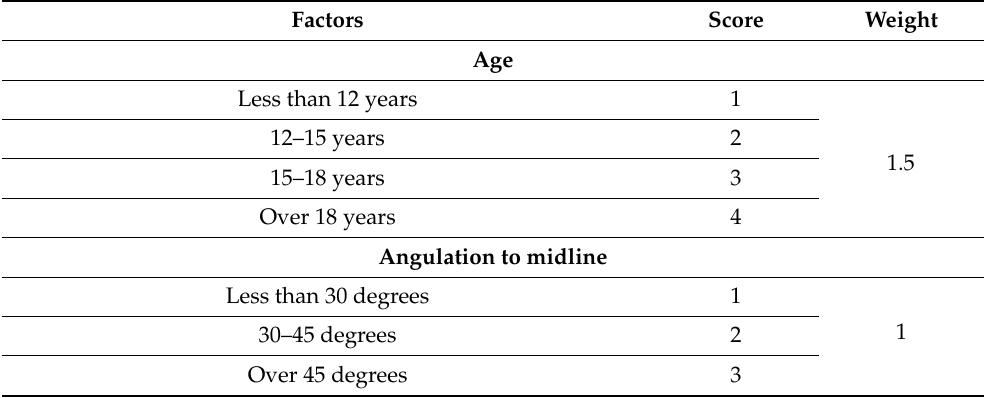
Table 1. Grading score and weighting of the orthodontic treatment difficulty index.